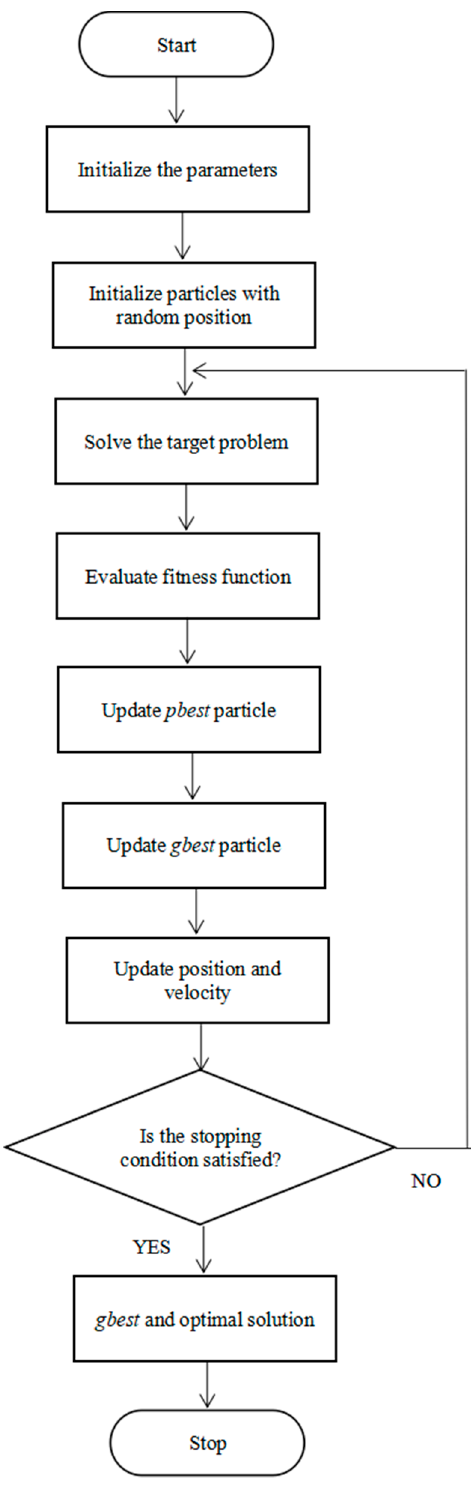
Figure 1. Flowchart of Particle Swarm Optimization (PSO).